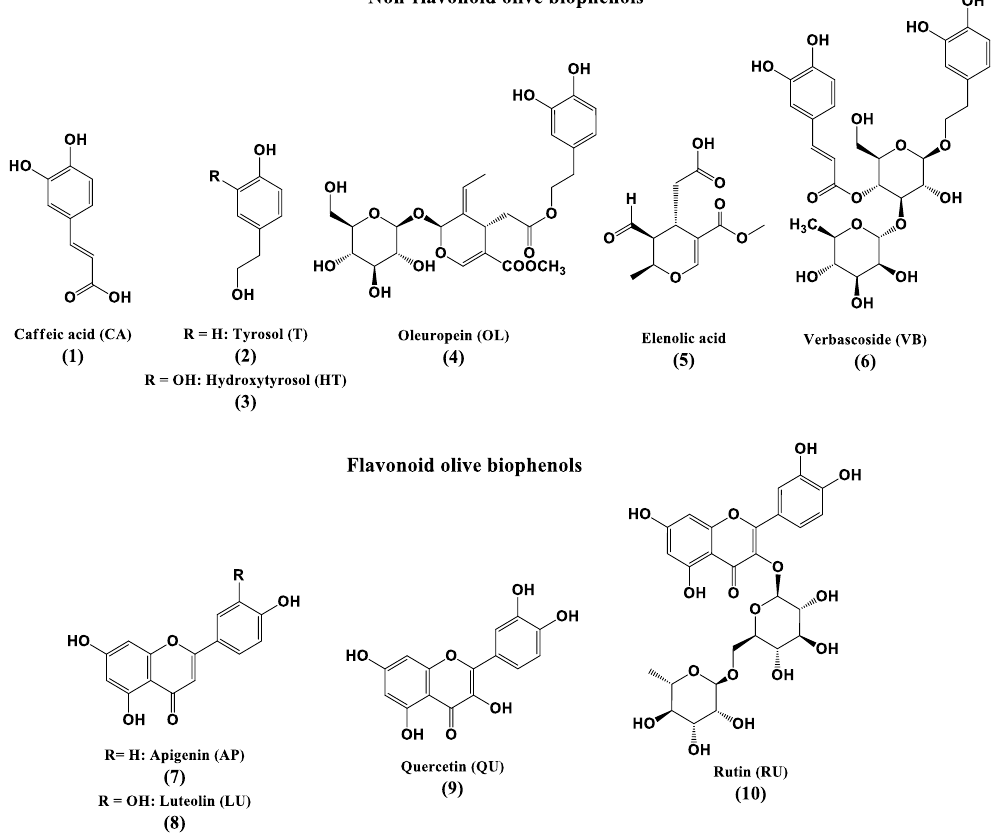
Figure 1. Structures of the major non-flavonoid and flavonoid olive biophenols.